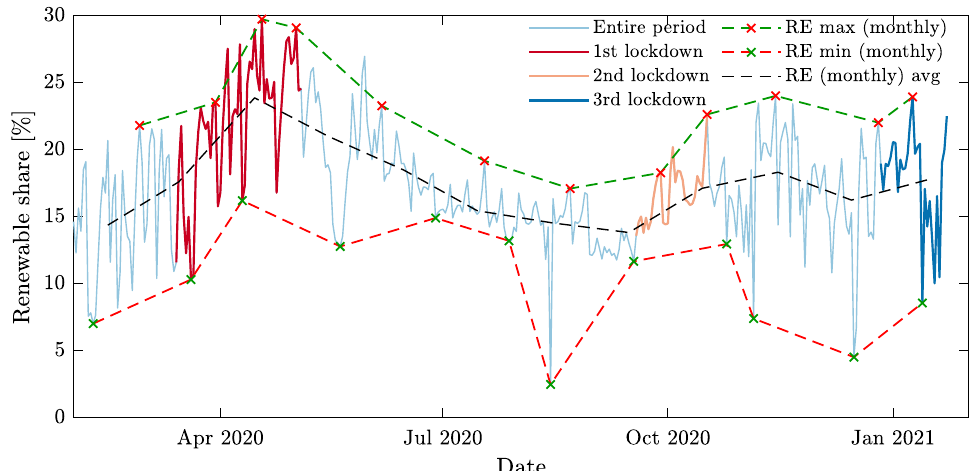
Figure 2. Renewable energy (RE) share (mainly solar) in Israel from 1 February 2020 to 23 Jan- uary 2021.